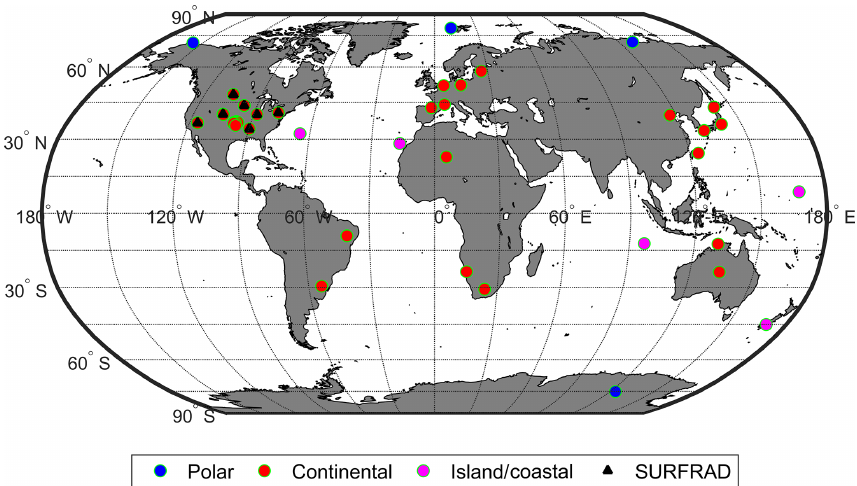
Figure 1. Geographical distribution of in situ observation sites used for evaluation of space-based products. The blue, red and magenta circles (with green border) denote the polar (Arctic or Antarctic), island or coastal, and continental sites, respectively, and the black triangle represents the SURFRAD